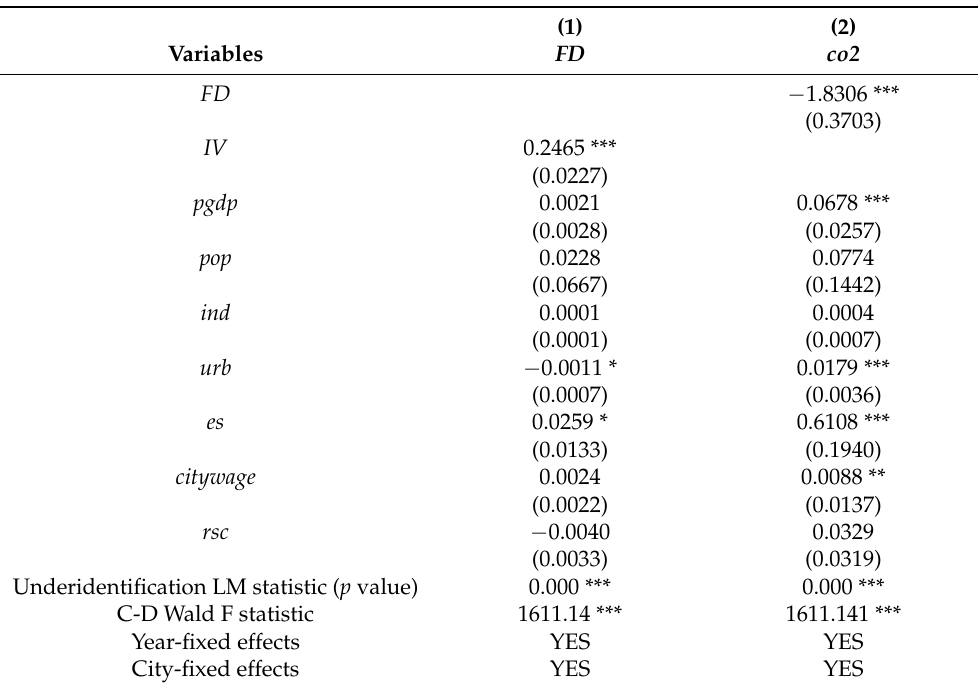
Table 3. IV estimation